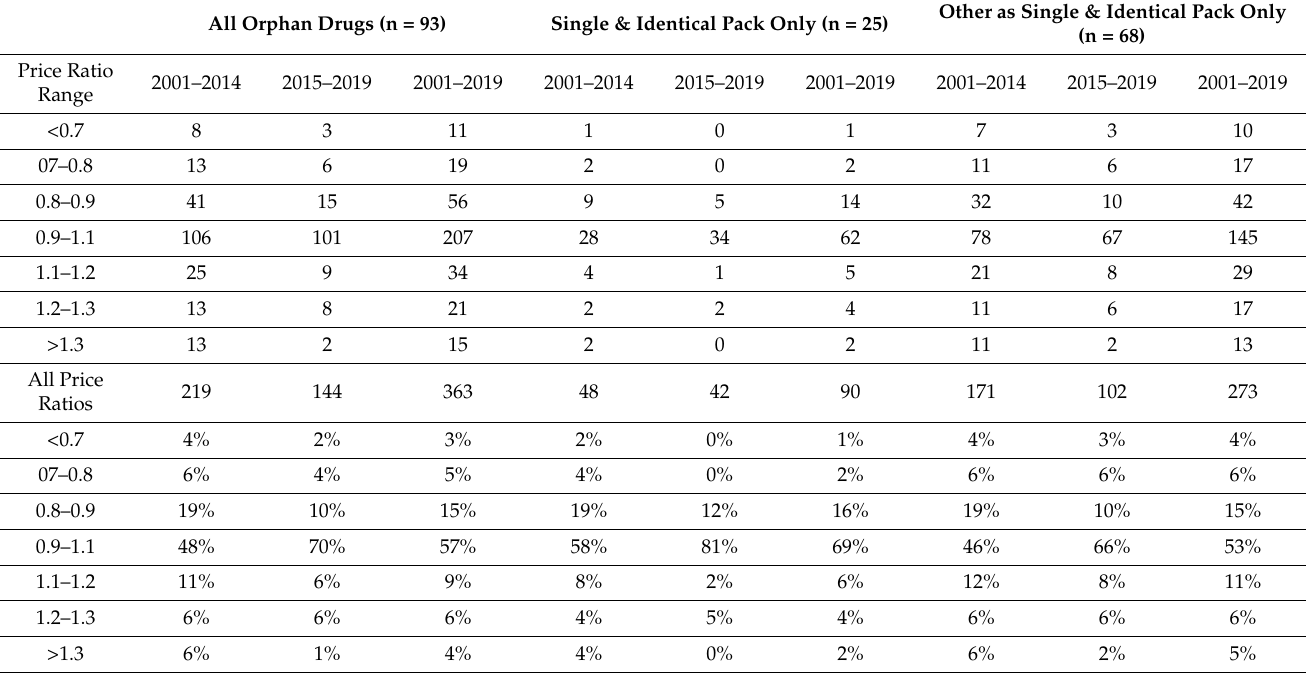
Table 4. Price Ratios EU Individual Country/Average Price from six EU Countries. Distribution.